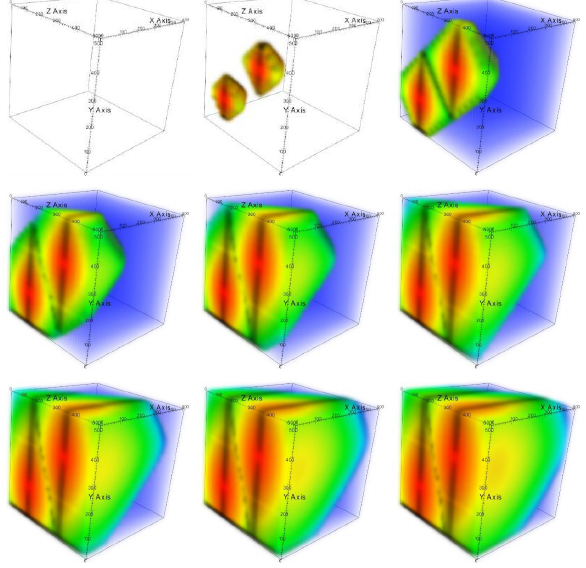
Figure 5. Simulation results of experiment 2 (every 10